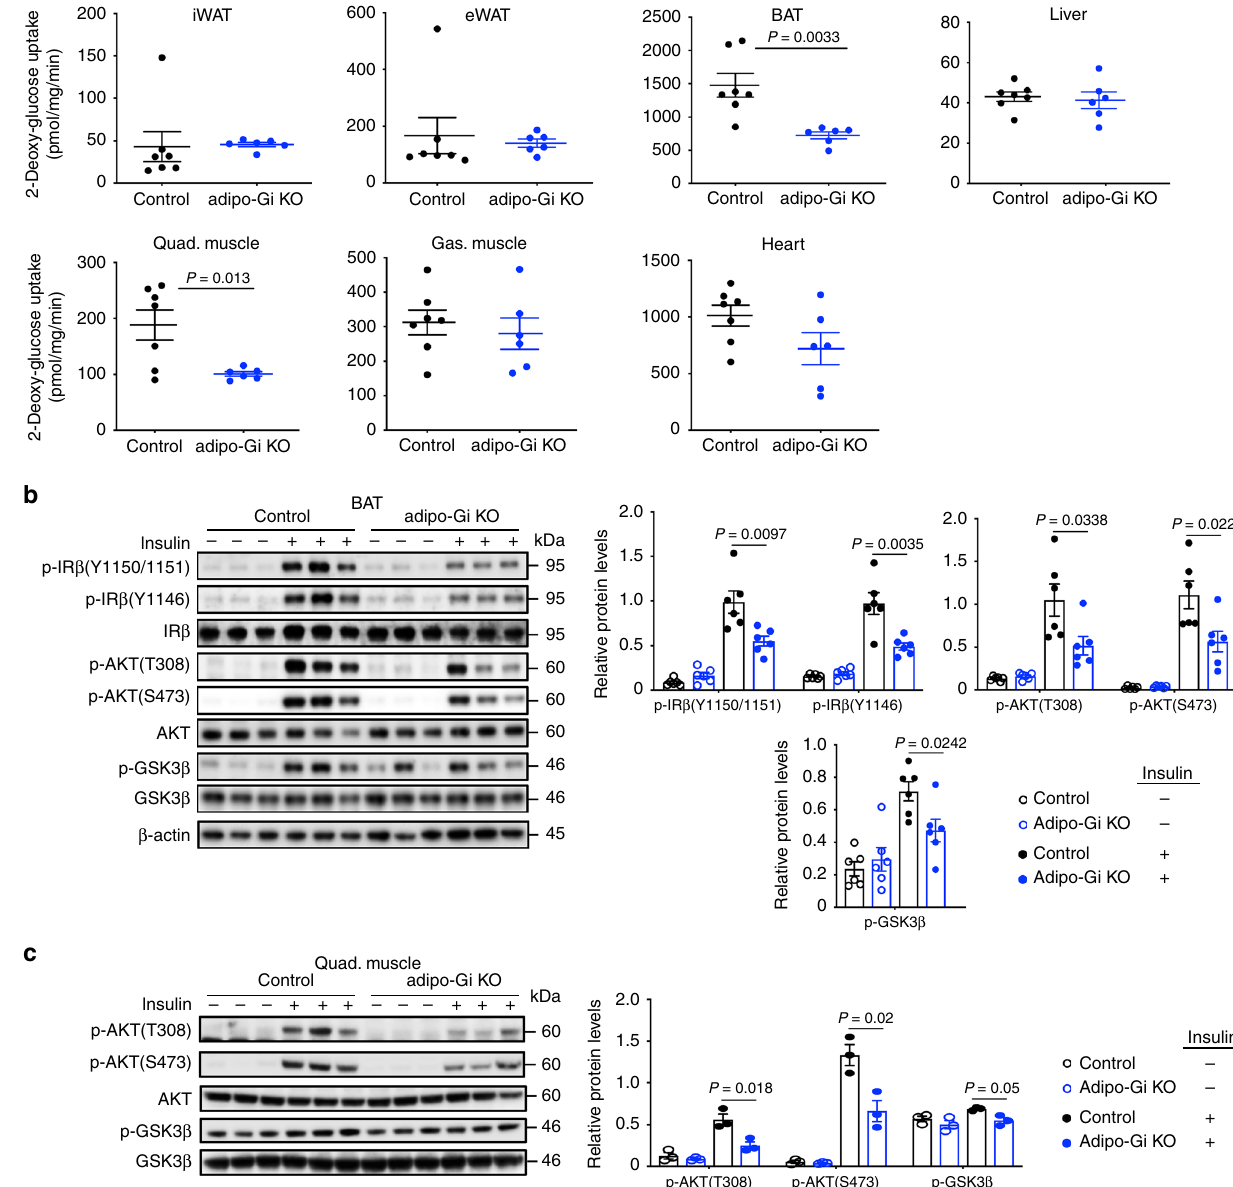
Fig. 6 HFD adipo-Gi KO mice show impaired glucose uptake and insulin signaling in BAT and skeletal muscle. a In vivo 2-deoxy-glucose uptake studies. Control and adipo-Gi KO mice (males) maintained on a HFD for 8 weeks received an i.p. insulin injection (0.75 U/kg). Insulin-stimulated glucose uptake into inguinal white adipose tissue (iWAT), epididymal WAT (eWAT), brown adipose tissue (BAT), quadriceps muscle (Quad.), gastrocnemius muscle (Gas.), liver, and heart was studied using the 2-deoxy-glucose method (control, n = 7; adipo-Gi KO, n = 6). b , c Western blotting analysis of insulin signaling in BAT ( b ) ( n = 6 per group) and quadriceps muscle ( c ) ( n = 3 per group). HFD control and adipo-Gi KO mice were injected i.v. with either saline or insulin (5 U). Tissues were collected 5 min later and processed for immunoblotting studies. Data are given as means ± s.e.m. P values are indicated in the different panels ( a : two-tailed Student ’ s t test; b , c : two-way ANOVA followed by Bonferroni ’ s post hoc test). Source data are provided as a Source data fi